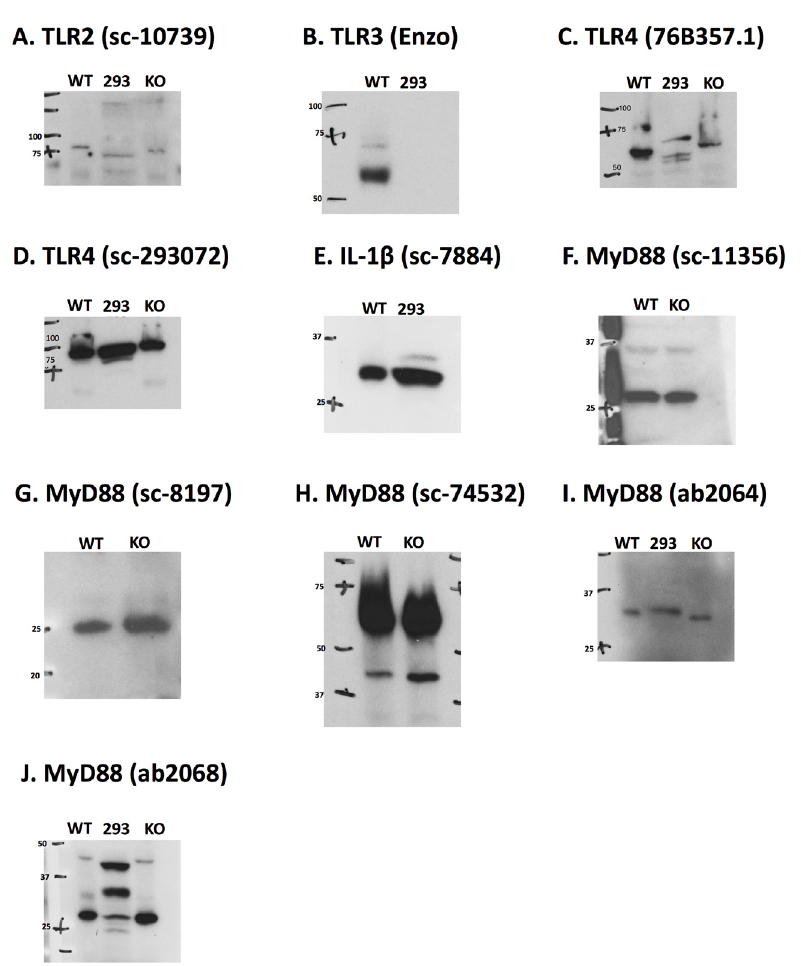
Figure 6. Antibody validation. Antibody tests in negative controls (knockout tissue and HEK-293 cells). Each antibody was run once with just knockout tissue if available, and once with knockout tissue and HEK 293T cell lysates. A. The TLR2 antibody produces a signal in HEK-293 cells and TLR knockout tissue (KO), neither of which should express TLR2. B. The TLR3 antibody only produced signal in the WT tissue. C and D. Both TLR4 antibodies produced signals in the HEK-293 cells and the TLR4 knockout tissue, neither of which should express TLR4. E. The IL-1 β antibody produced a signal in the HEK-293 cells, which should not express IL-1 β . F – J. All five MyD88 antibodies produced a signal in the MyD88 knockout tissue.